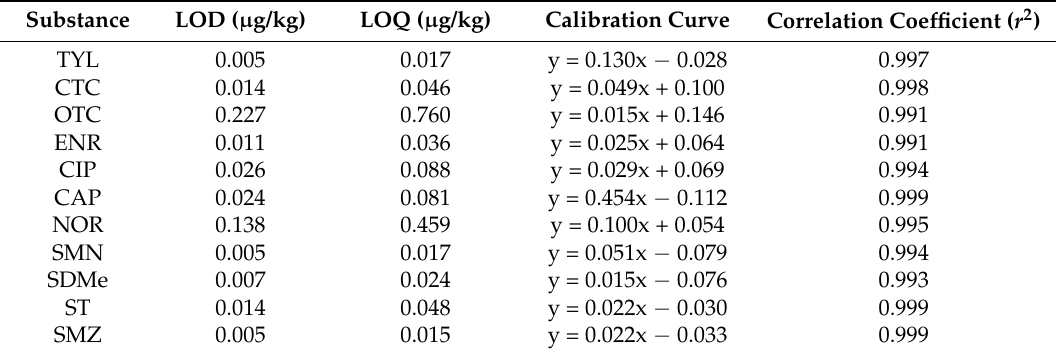
Table 2. The LOD ( µ g/kg) and LOQ ( µ g/kg) of the selected veterinary antibiotics.